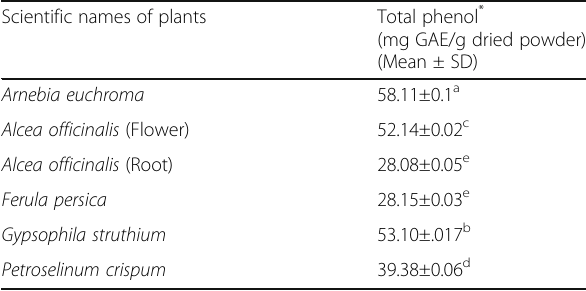
Table 3 The comparison of mean of total phenol content Scientific names of